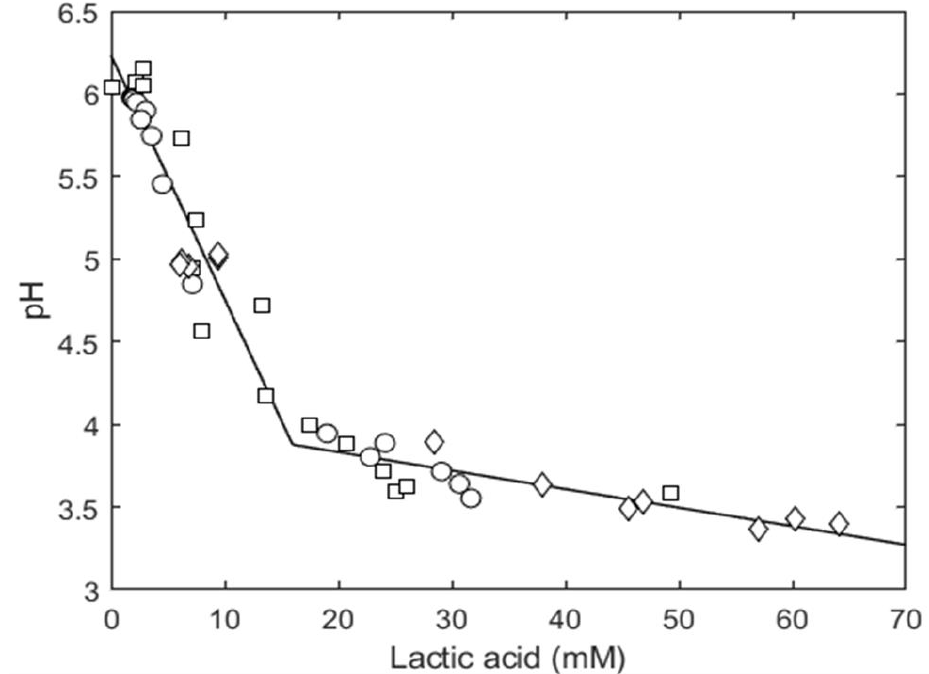
Figure 6. Evolution of pH of liquid sourdough as a function of the concentration of lactic acid. Comparison between experimental observations ( : Bio21B-1, : Bio21B-2, : Bio-21B -3).